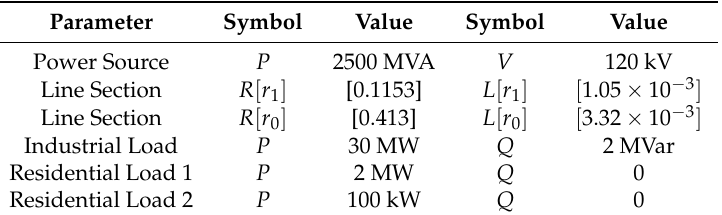
Table 2. Parameters at the PCC for different penetrations of active loads.